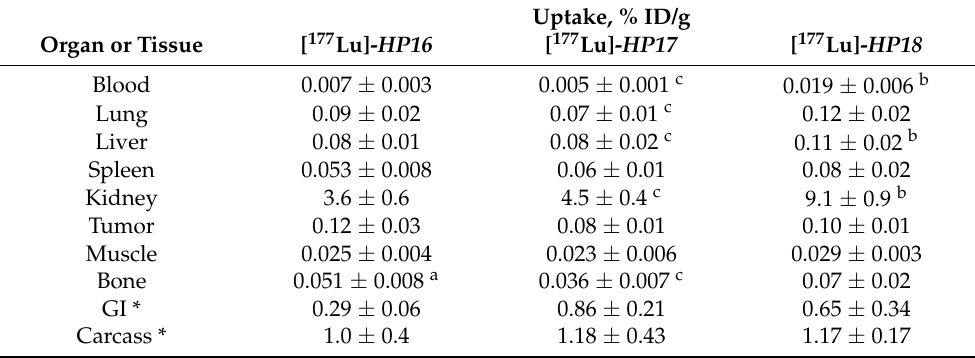
Table 4. Biodistribution of new 177 Lu-labeled secondary probes in BALB/C nu/nu mice bearing